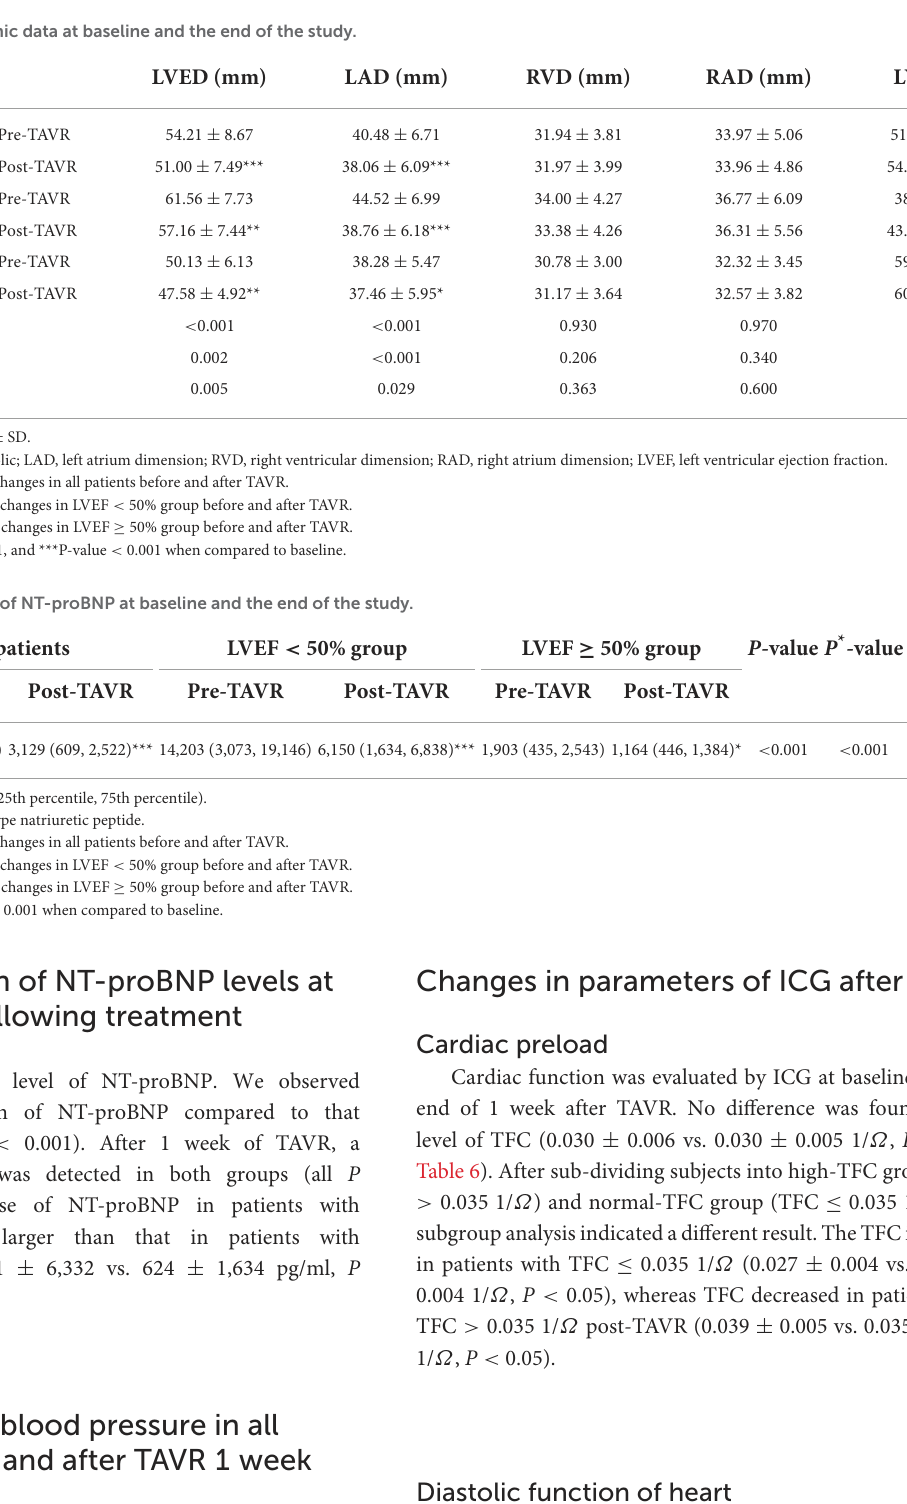
Our results revealed that TAVR improved the diastolic heart function as reflected by the decrease of LVET (303.99 ±